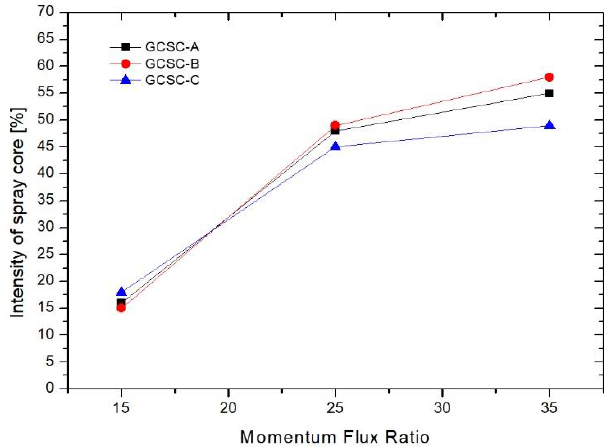
Figure 6. Intensity of spray core according to momentum flux ratio.